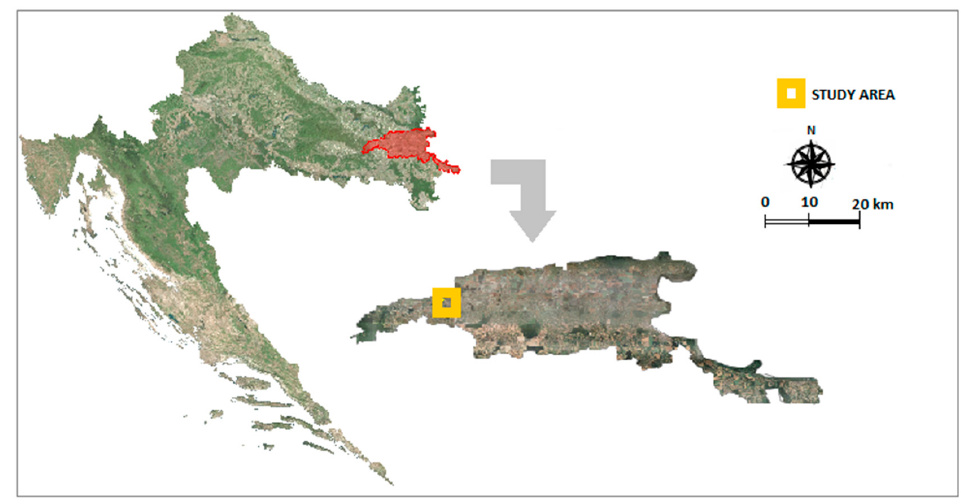
Figure 1. Position of study area in Croatia with designated position of study area, right side.